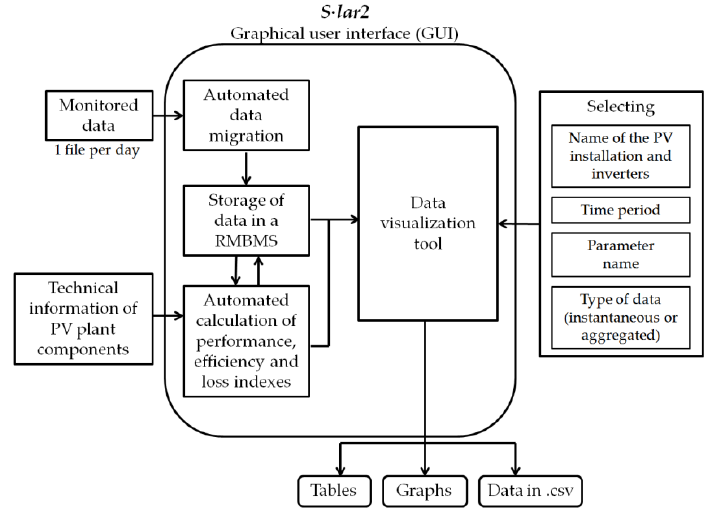
Figure 1. Esquematic diagram of the procedure used by S·lar 2 for the automated processing of monitored data in PV installations.